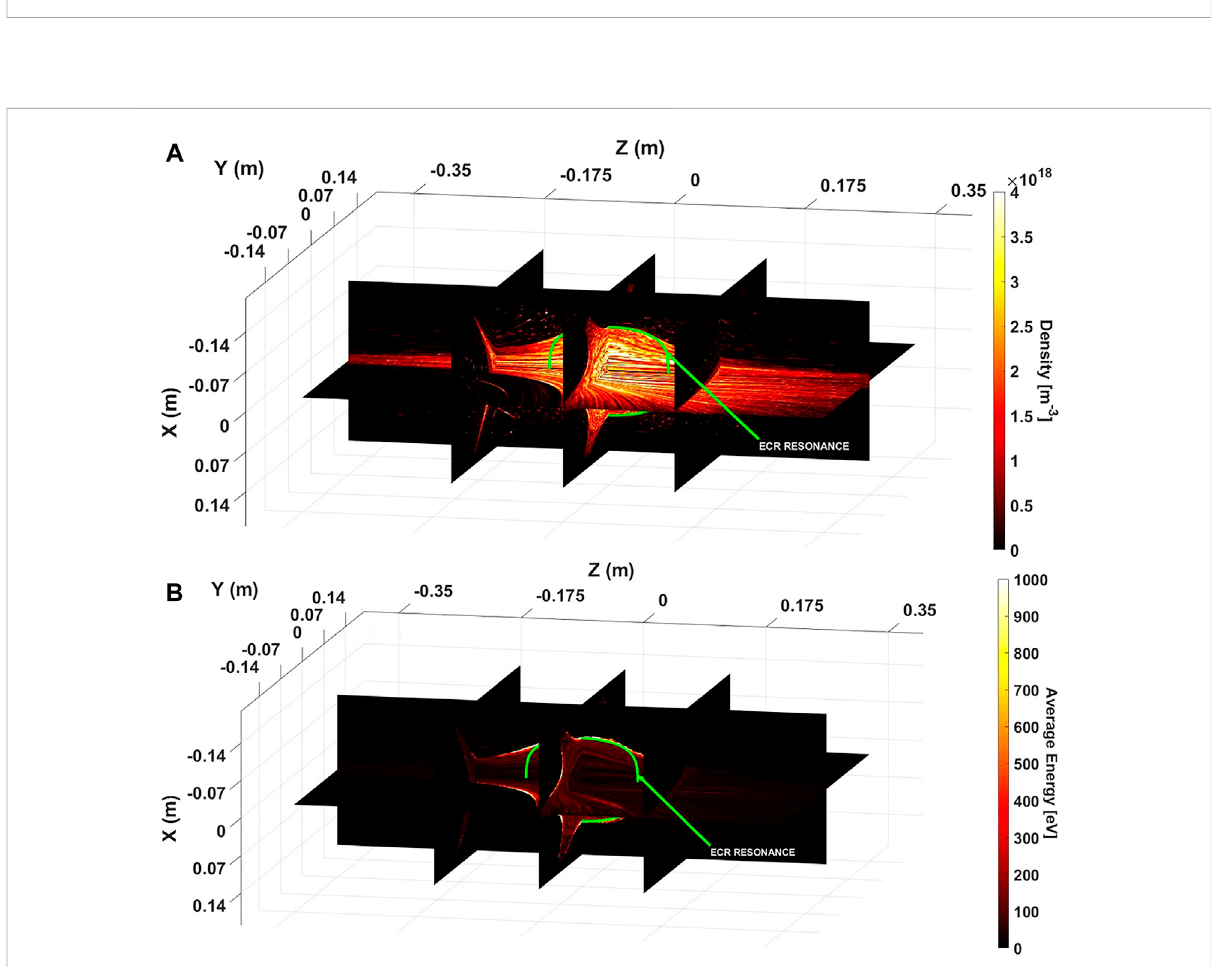
PANDORA ’ s plasma characteristics; (A) 3D total density; (B) average energy. The contour of the ECR resonance is indicated in